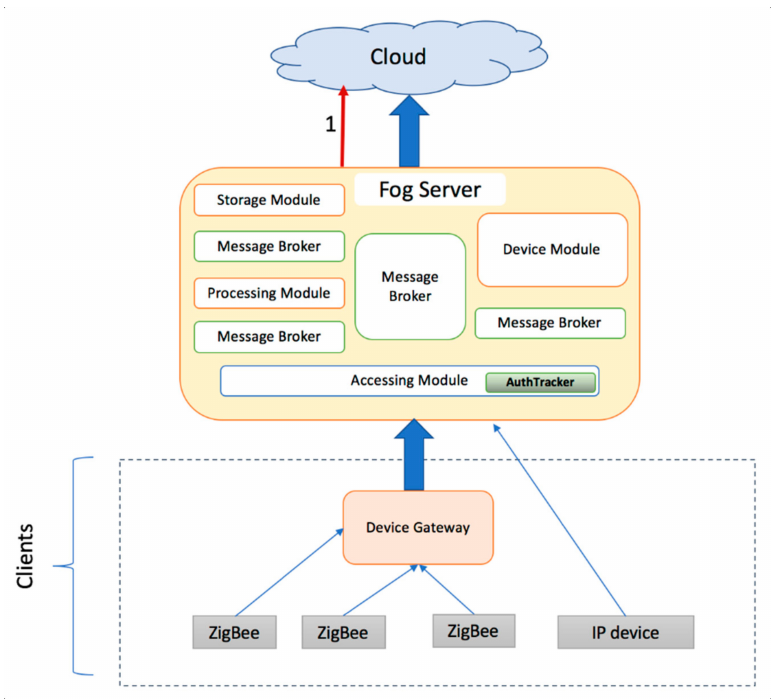
Figure 9. Synchronization